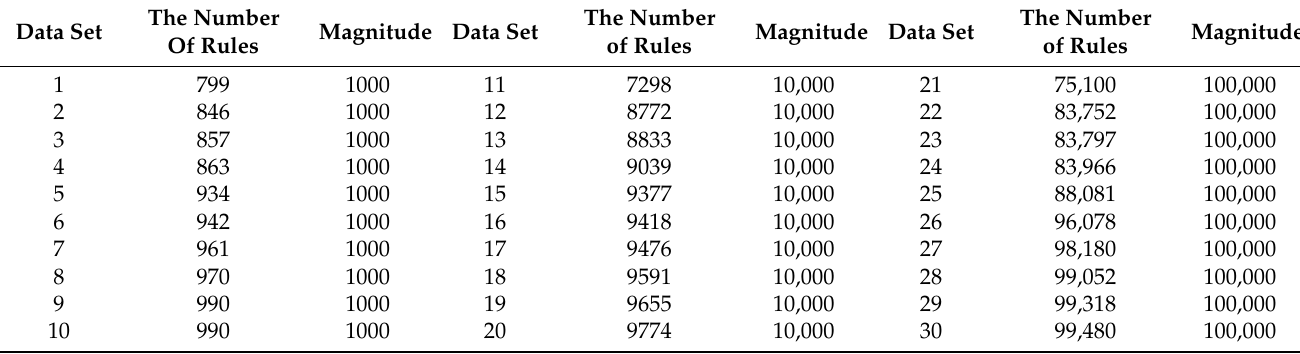
Table 2. The information of the rule data